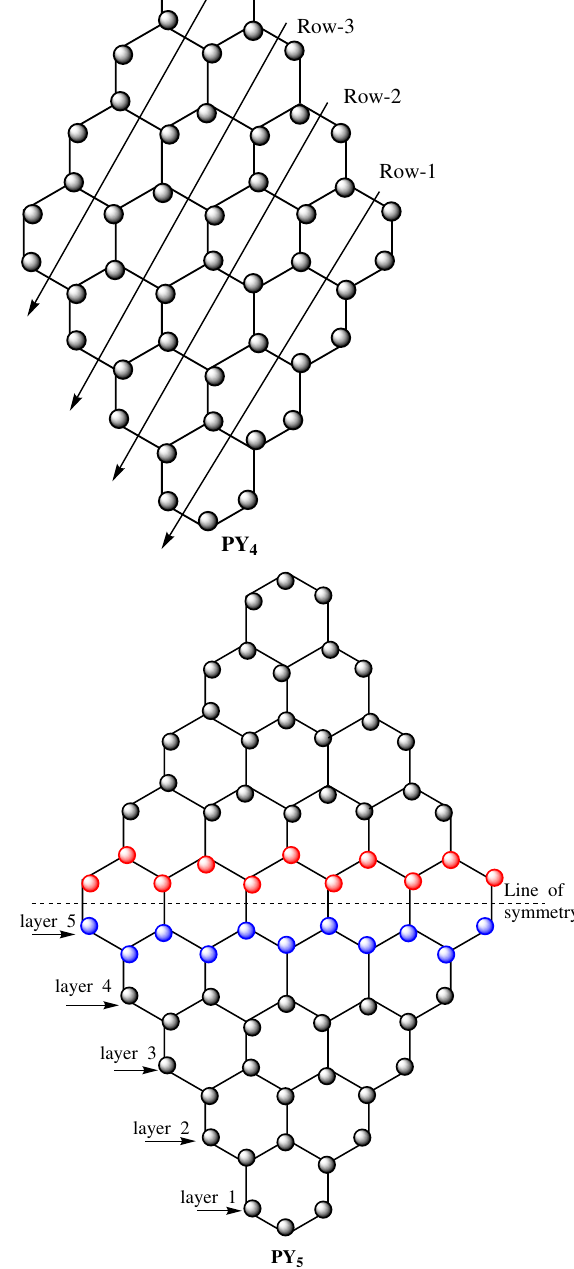
Figure 1. Pyrene network PY n